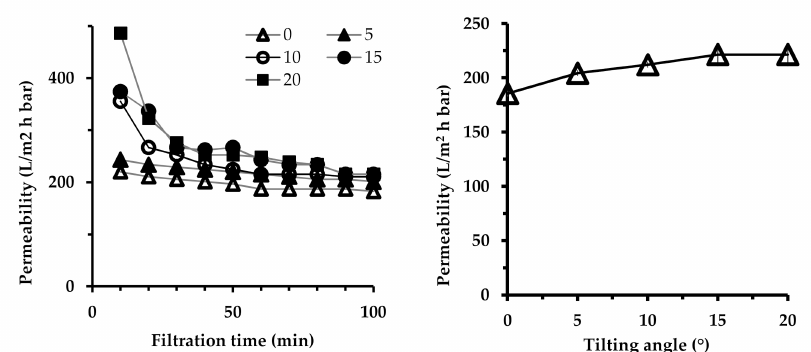
Figure 2. E ff ect of tilting angle on the steady-state permeability at constant aeration rate (1.5 L / min) as function of time ( left ) and the summary of the steady-state permeability values ( right